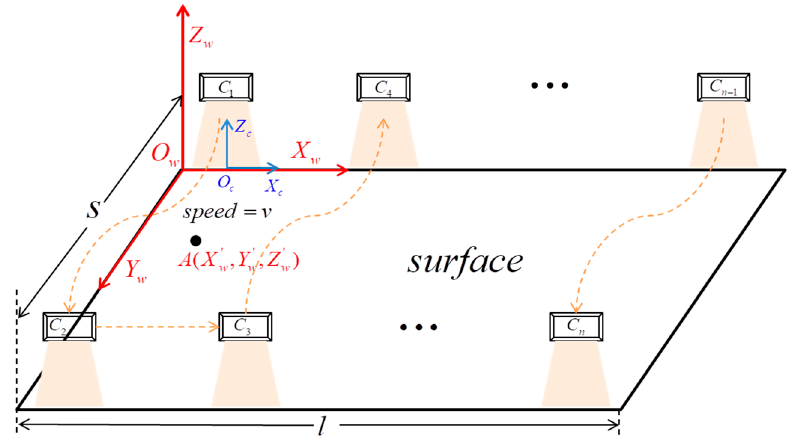
Figure 5. Coordinate system of profilometer carrier and world coordinate system of measuring area.